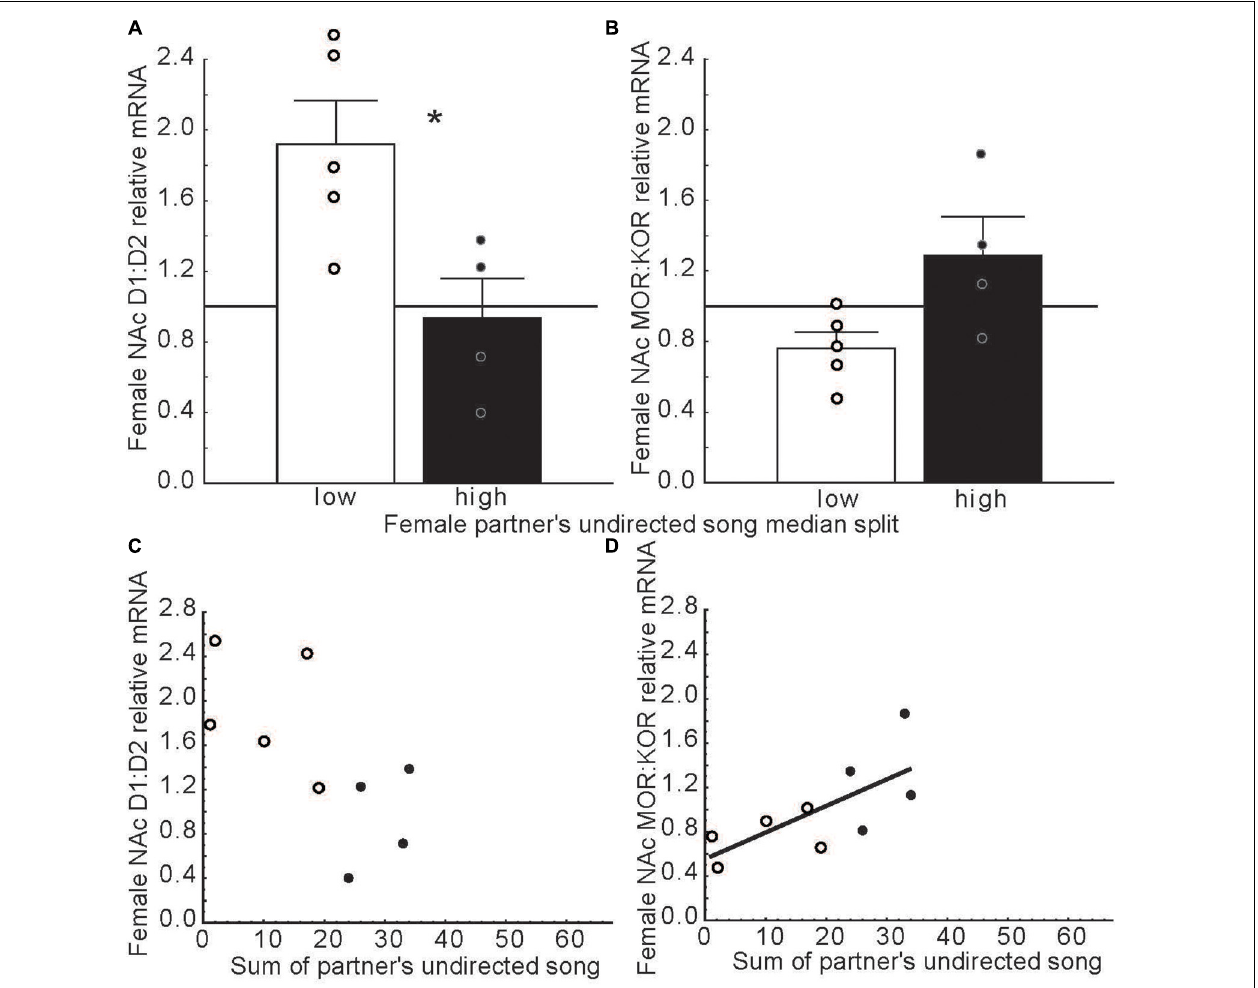
FIGURE 8 | Dopamine and opioid receptor mRNA ratios in NAc differ in females whose partners produced low versus high rates of undirected song. (A,B) Mean relative mRNA ratios + sem for D1:D2 and MOR:KOR in females paired with males that produced low (open bars) or high (filled bars) rates of song as determined using a median split. The point at which ratios diverge from 1:1 is indicated by a horizontal line. (C,D) Scatterplots illustrating relationships between dopamine and opioid receptor mRNA ratios in the female NAc and the number of undirected songs produced by her partner. Each point represents an individual female. Open dots indicate females with male partners that sang at low and filled dots represent partners that sang at high rates in bar graphs. The regression line indicates a significant correlation ( p < 0.05). Data from Alger et al. (2021). Reproduced with permission.